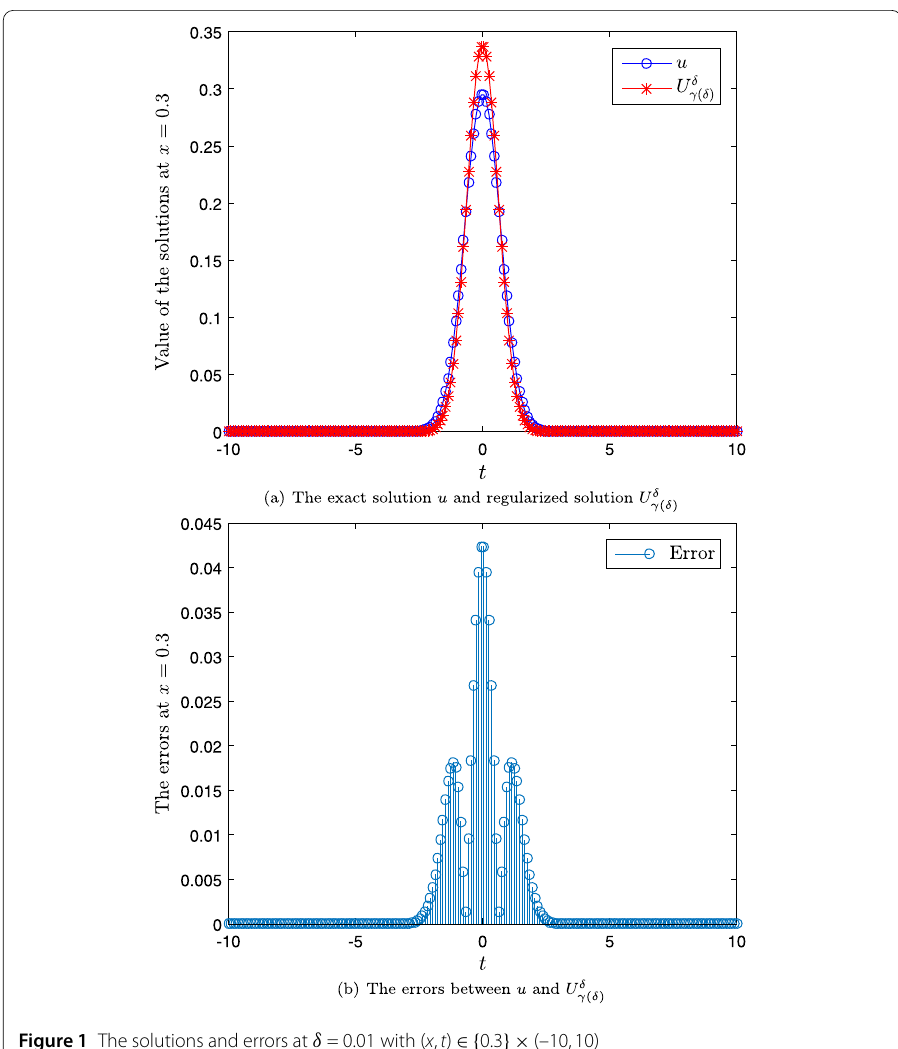
Figure 1 The solutions and errors at δ = 0.01 with ( x , t ) ∈ { 0.3 } ×